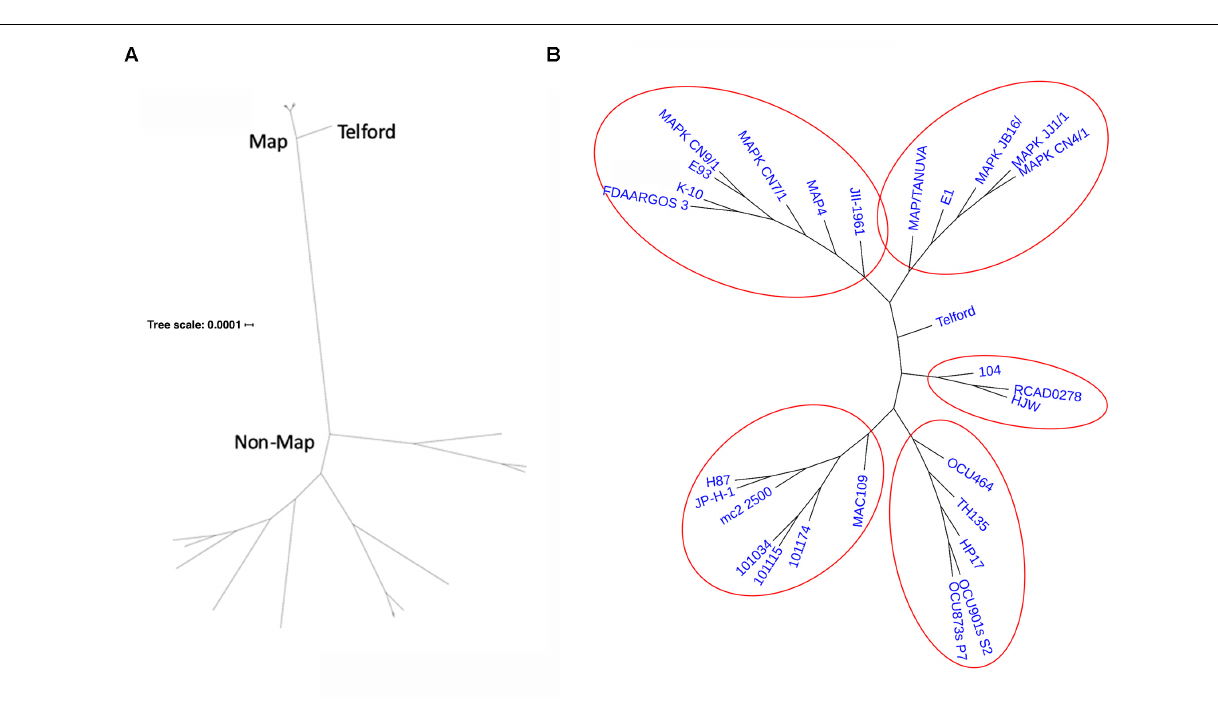
( Figure 10A ). A striking number of recombination events is detected by this analysis in non- Map strains relative to Map (compare dark blue squares in Figure 10B ). These events